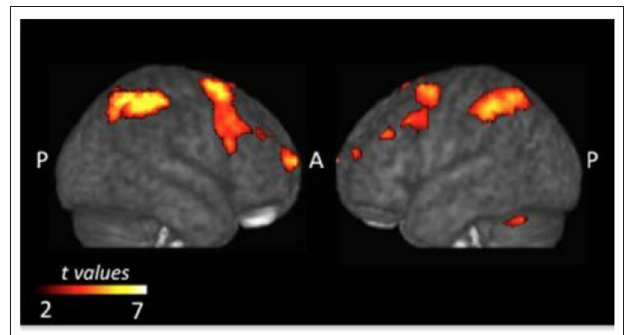
FIGURE 2 | Common brain regions that were more active during the acquisition phase of both types of learning. Adopted from Monfardini et al. (2013) under Creative Commons Attribution License (CC